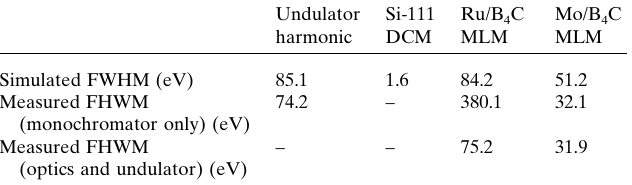
Figure 2 Measured absolute photon flux of the seventh harmonic peak of the undulator spectrum. The main peak has an FWHM of (cid:2) E = 73.2 eVand the FWHM is shown as gray dashes. This curve is the envelope which determines the available energy bandwidth for the multilayer mono- chromator. The gap opening was 5.665 73.2 eV or (cid:2) E / E = 0.61%. A plot of the measured spectrum is given in Fig. 2.